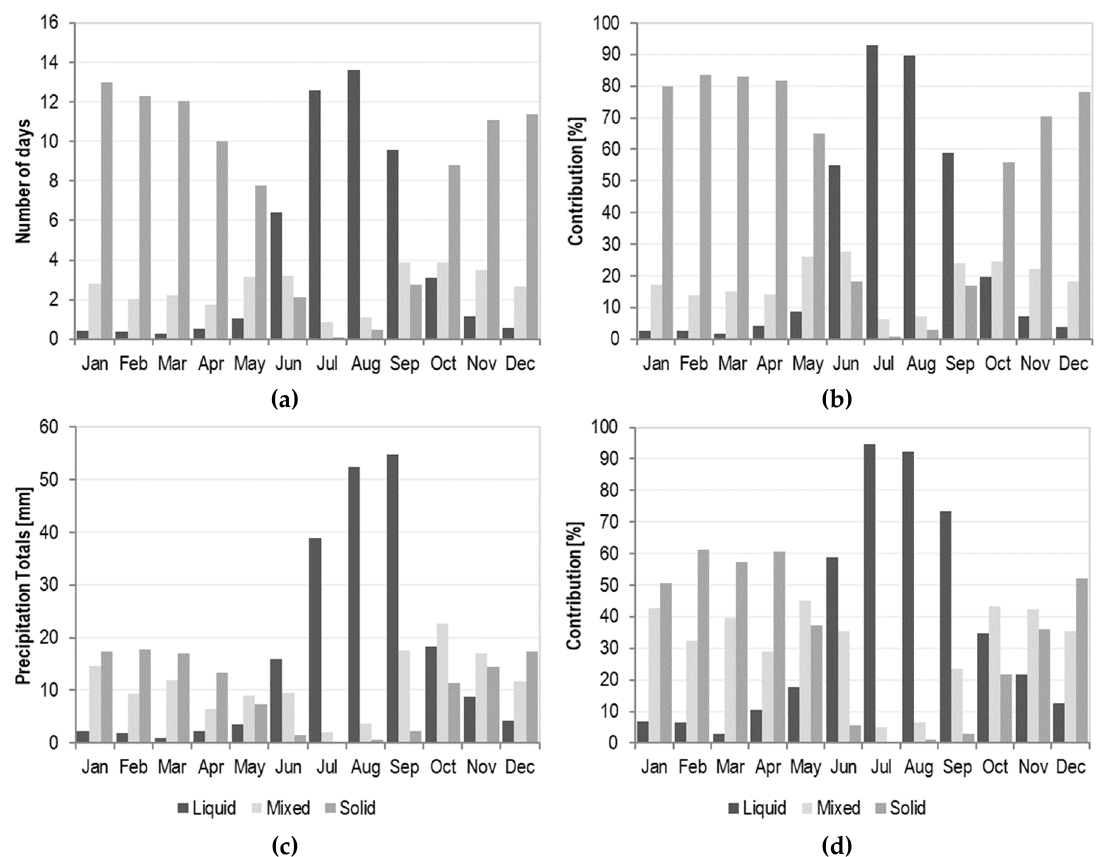
Figure 2. Annual course of liquid, solid, and mixed precipitation at Hornsund meteorological station (1979 ‒ 2017): ( a ) number of days with precipitation, ( b ) contribution of precipitation forms to monthly number of days with precipitation, ( c ) precipitation totals, and ( d ) contribution of precipitation forms to monthly precipitation totals.